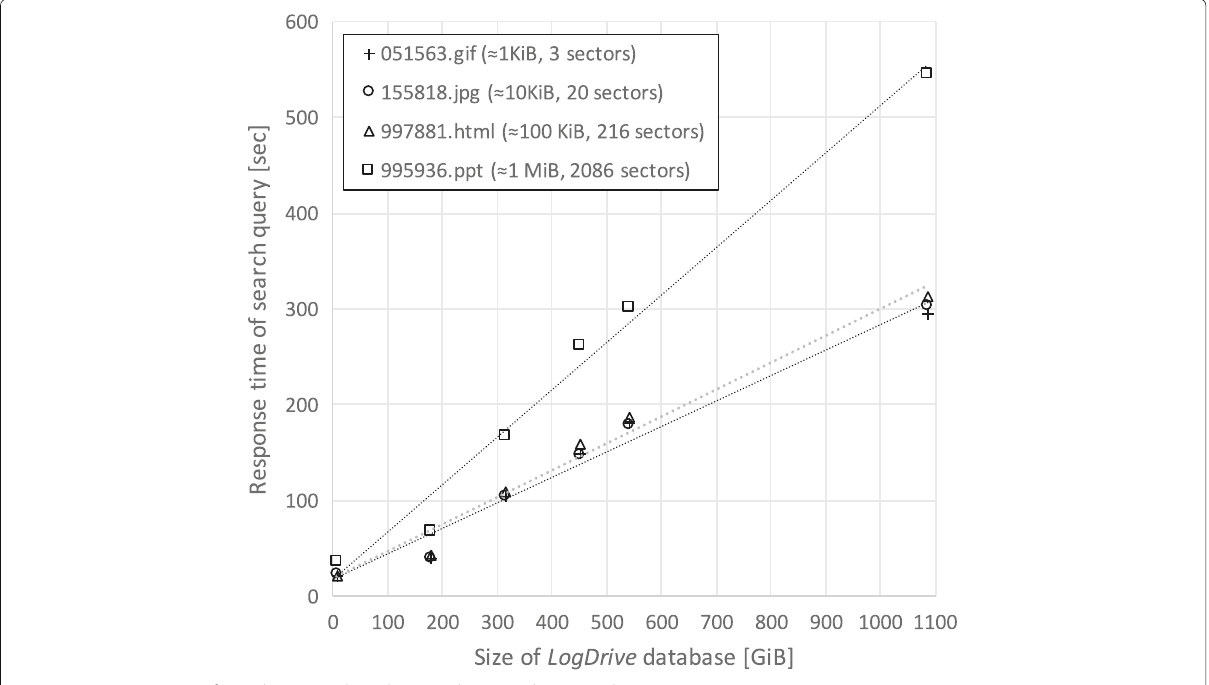
Fig. 11 Response time of search query (Algorithm 4 without random